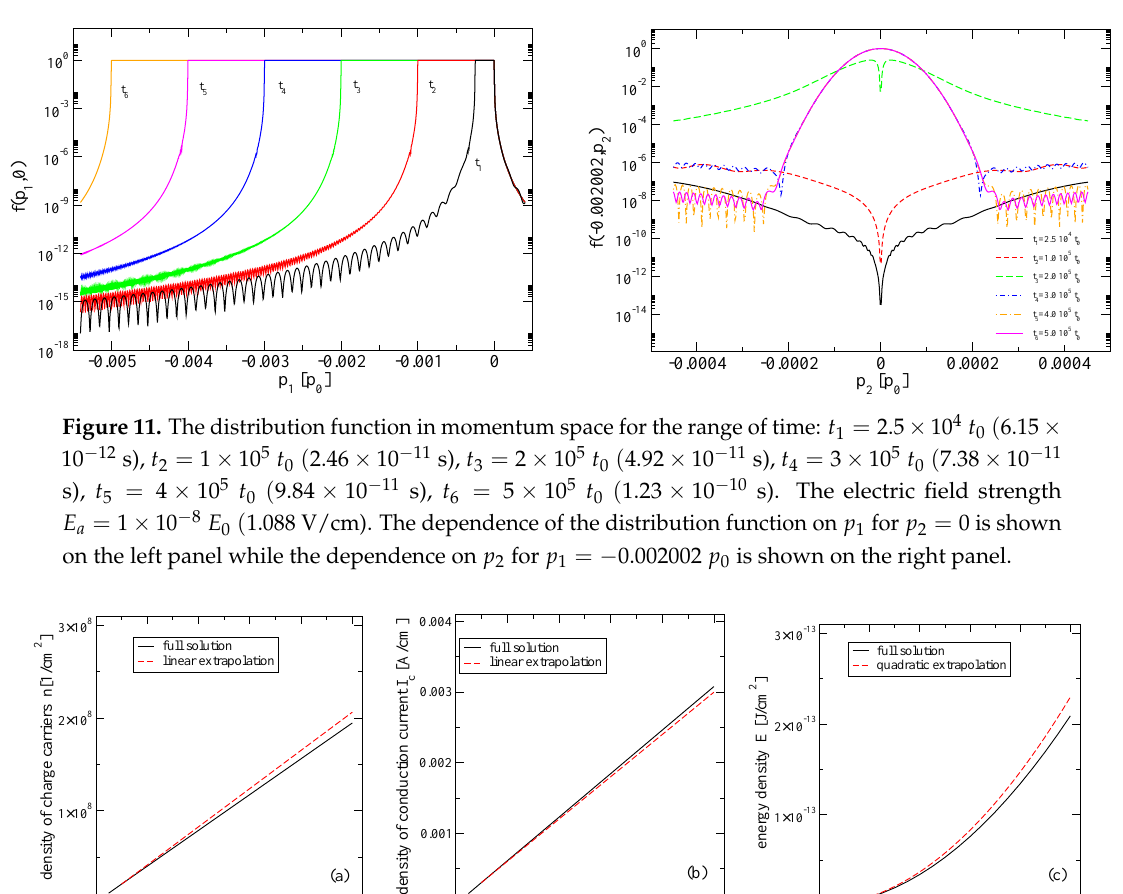
0 Figure 12. From left to right: density of charge carriers (42), density of conduction current and energy density the carriers for range of the time 25,000 t 0 − 500,000 t 0 (6.15 × 10 − 12 s − 1.23 × 10 − 10 s ). The constant electric field strength E a = 1 × 10 − 8 E 0 ( 1.088